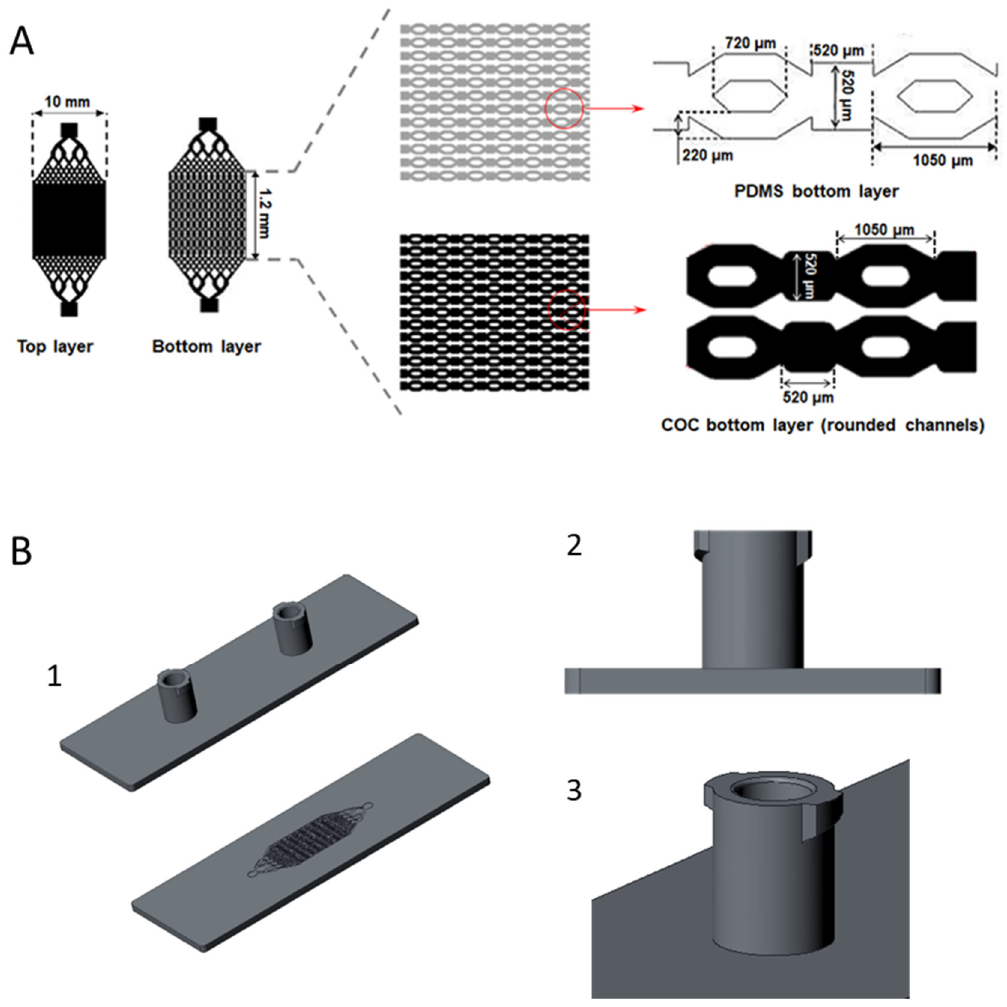
Figure 1. ( A ) Design of the biochip layers, ( B ) CAD design of COC bioreactor: (1) complete Biochip, (2) and (3) Luer lock connectors.